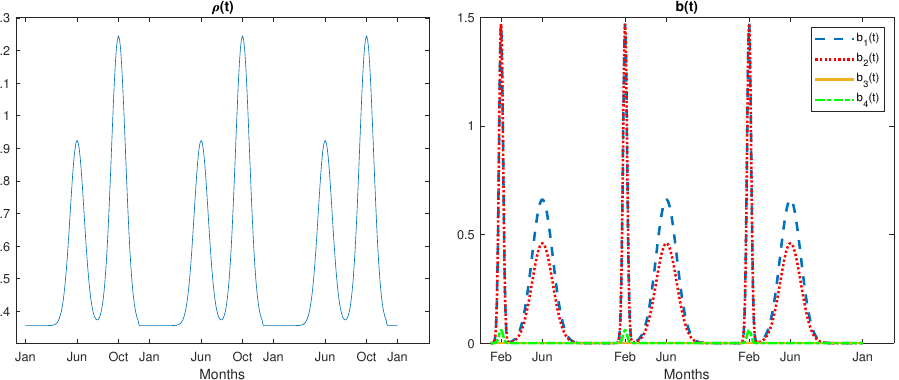
Figure 2. The function ρ ( t ) (on the left) and the vectorial function b ( t ) (on the right) in a three-year